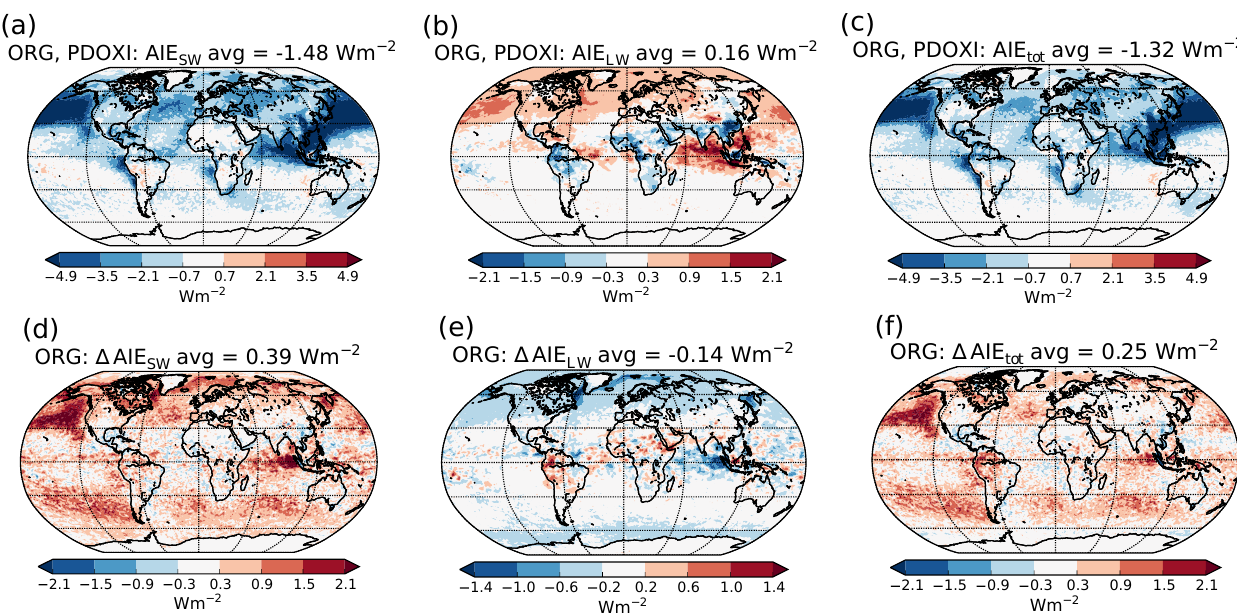
Figure 3. (a) – (c) PD–PI aerosol indirect effect when using the standard setup with PD oxidants in both simulations: (a) shortwave, (b) long- wave and (c) total. (d) – (f) Differences in the PD–PI indirect effect between simulations performed with PI and PD oxidants in the PI simulation.